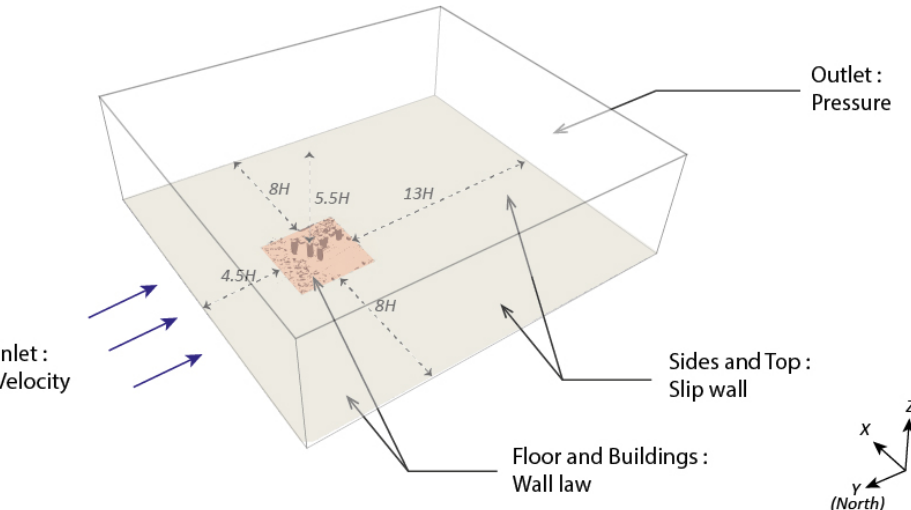
Figure 12 details the different model dimensions and boundary conditions used for the simulations.